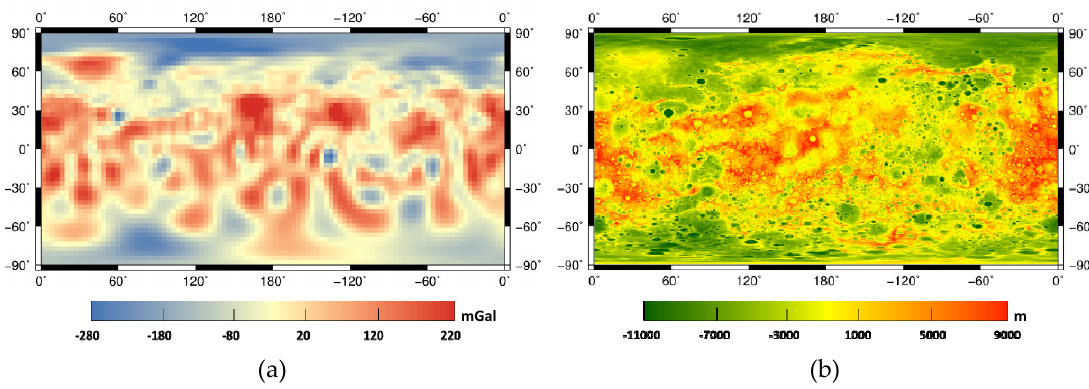
Figure 2. Mercury’s gravity data and DEM product. ( a ) 50-degree HgM007; ( b ) The global digital elevation model (DEM) product of Mercury.